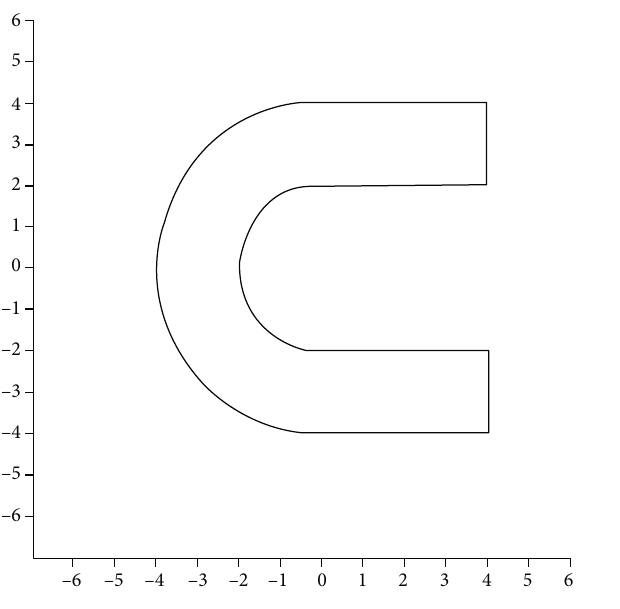
Figure 3: The set in Counterexample 3.4. Figure 4: The set in Counterexample